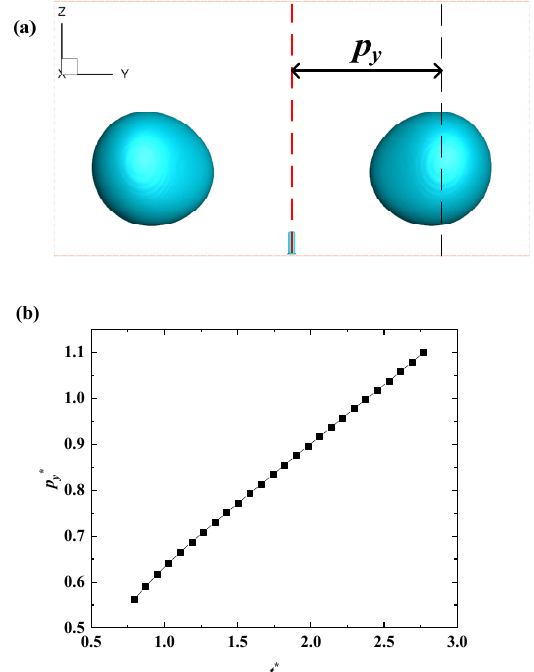
Figure 16. ( a ) The droplet morphology after bouncing off the S3 surface. ( b ) The dimensionless p y * as a function of time at a fixed L x * = 1.67.